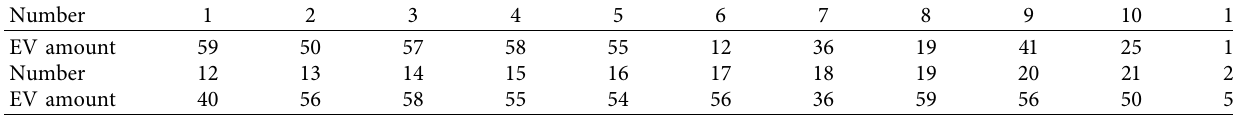
Table 8: Charging EV amount of each charging station.